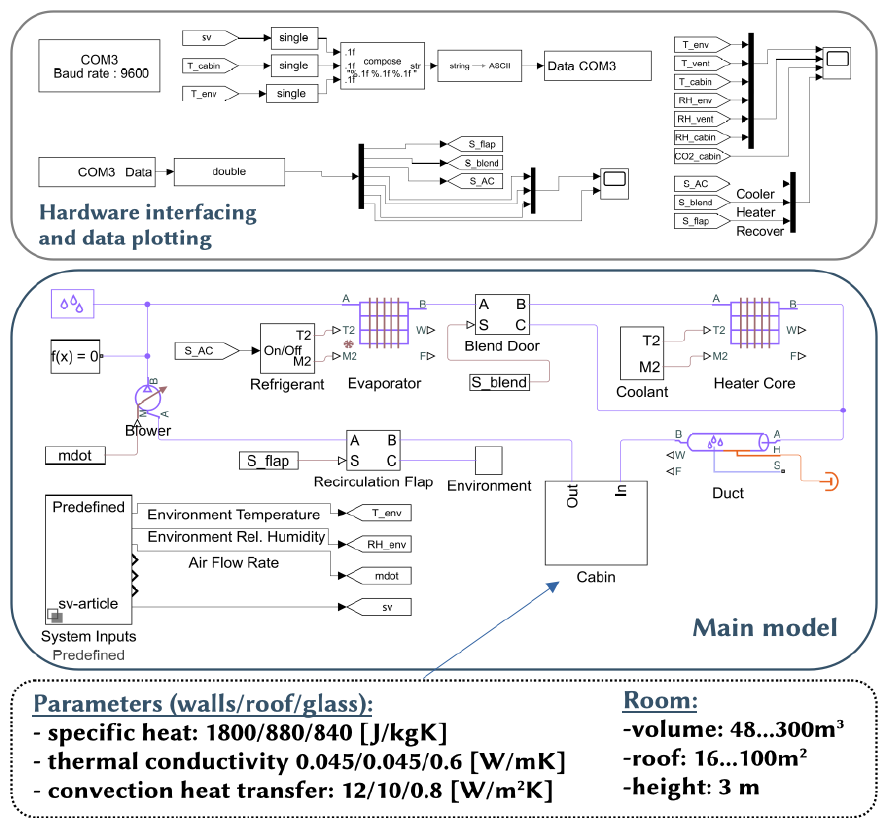
Figure 9. View of the Simulink layout of the room verification model and controller communication